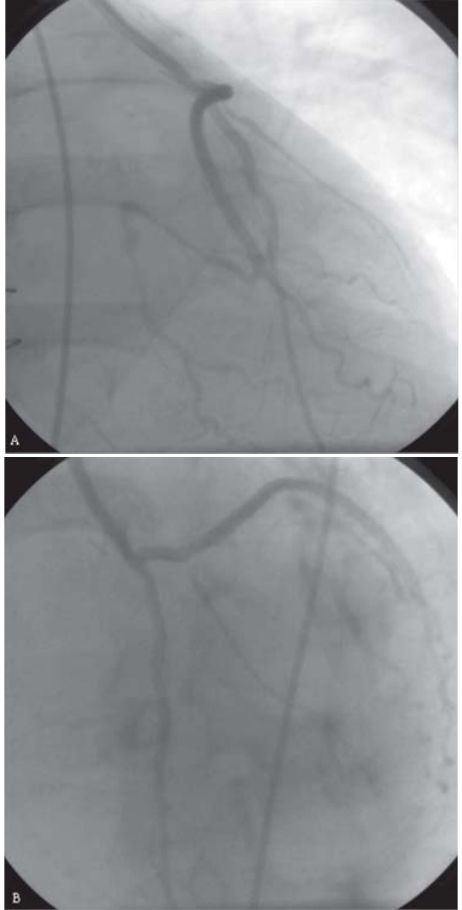
Fig. 1 – A: Projeção oblíqua anterior direita. B: projeção oblíqua anterior